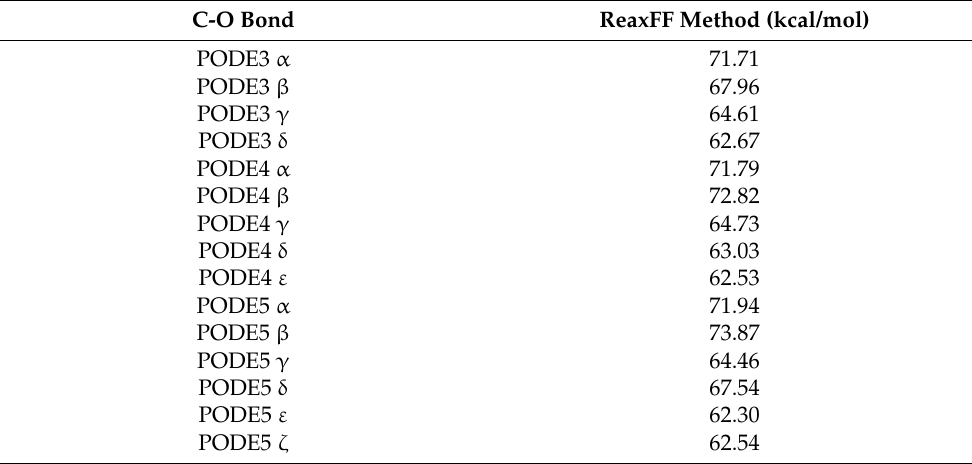
Table 1. Bond dissociation energies of C-O bonds in PODEn calculated using ReaxFF.